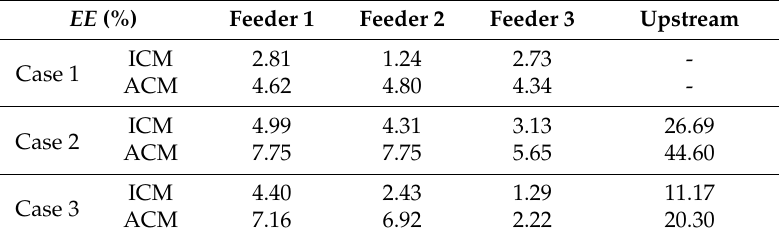
Table 6. Estimation errors ( EEs ) for the “ICM” and “ACM”.